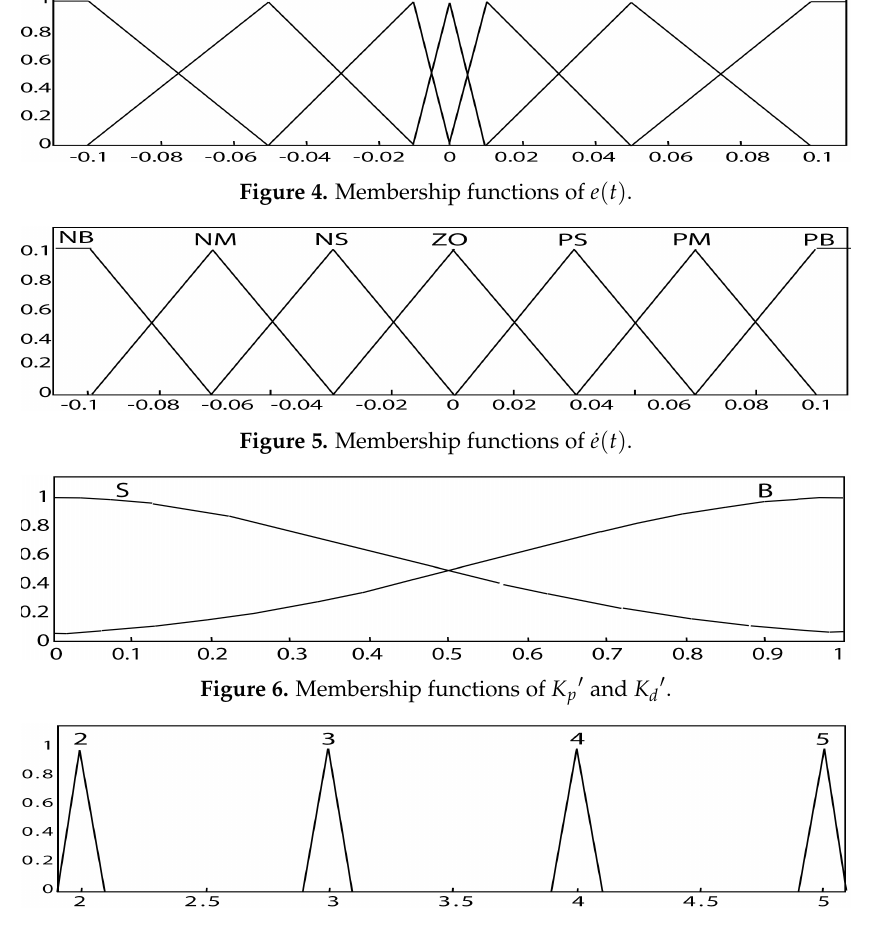
Figure 7. Membership functions of α